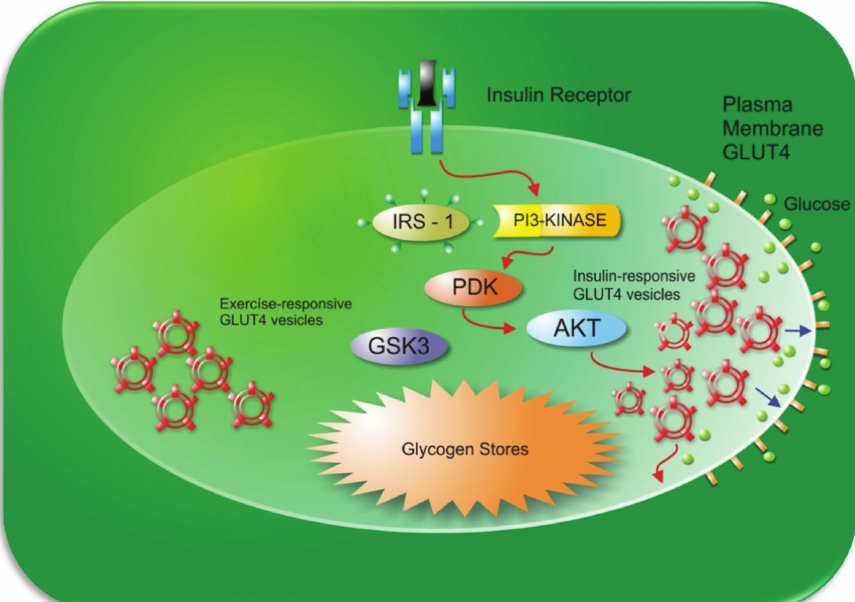
FIGURE 3 - Mechanisms responsible for the improvement in insulin action as a consequence of the skeletal muscle adaptation to the physical